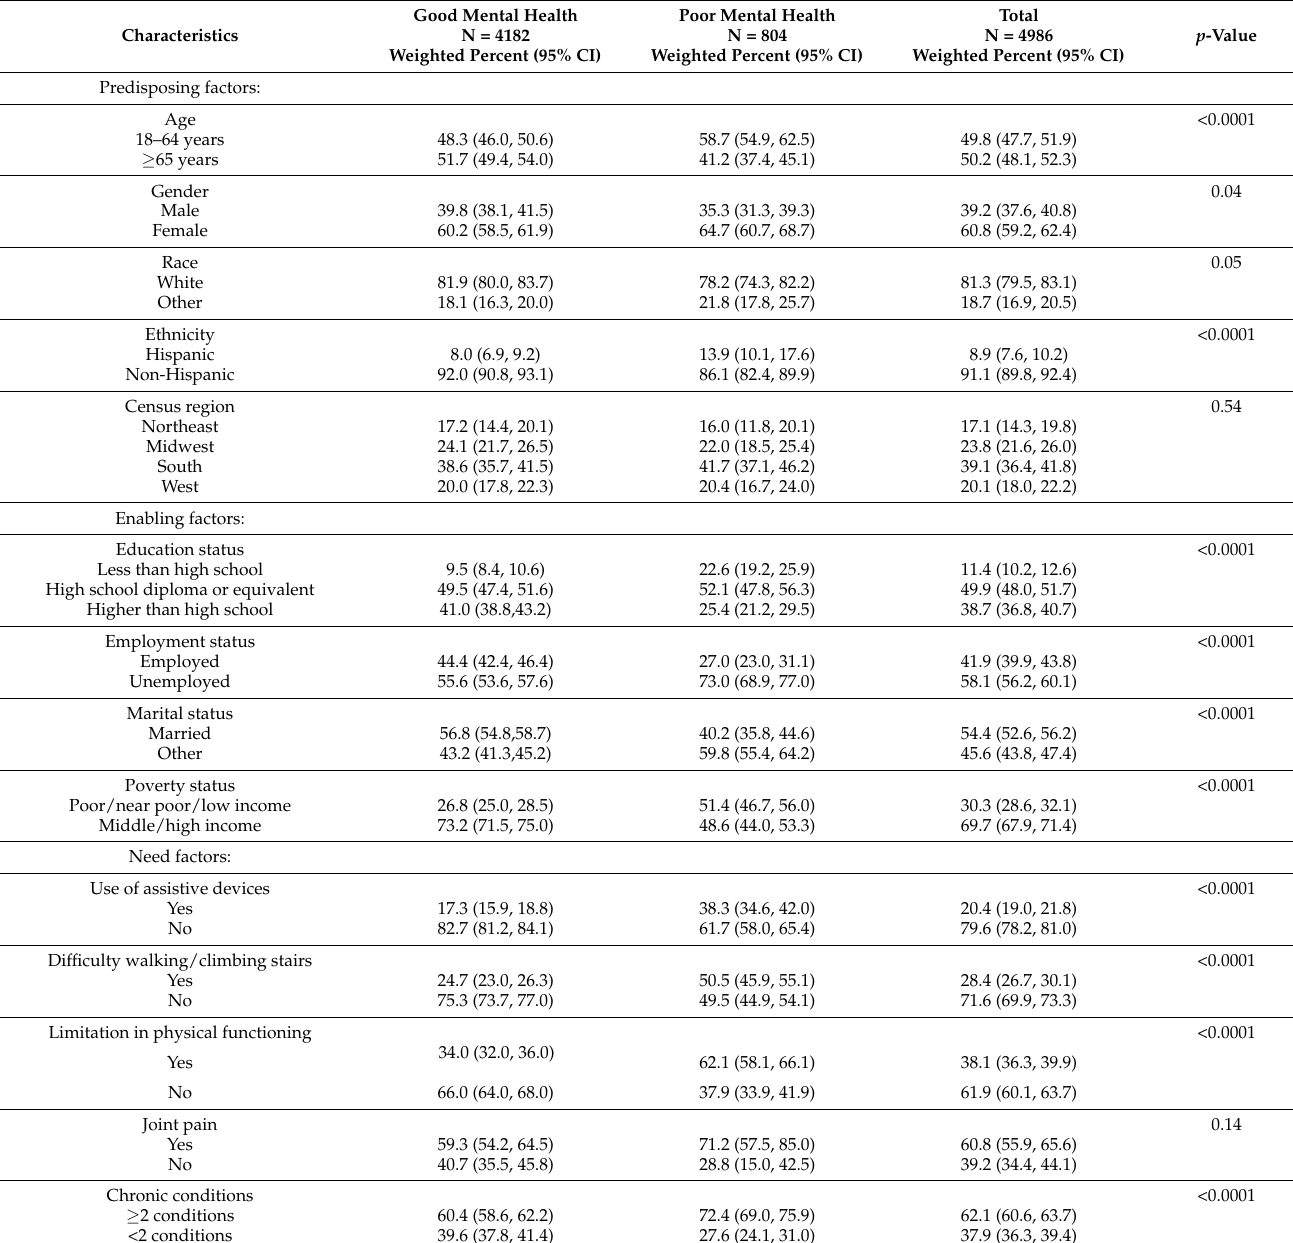
Table 1. Demographic characteristics of United States adults ( ≥ 18 years) with arthritis, stratified by good or poor self-perceived mental health